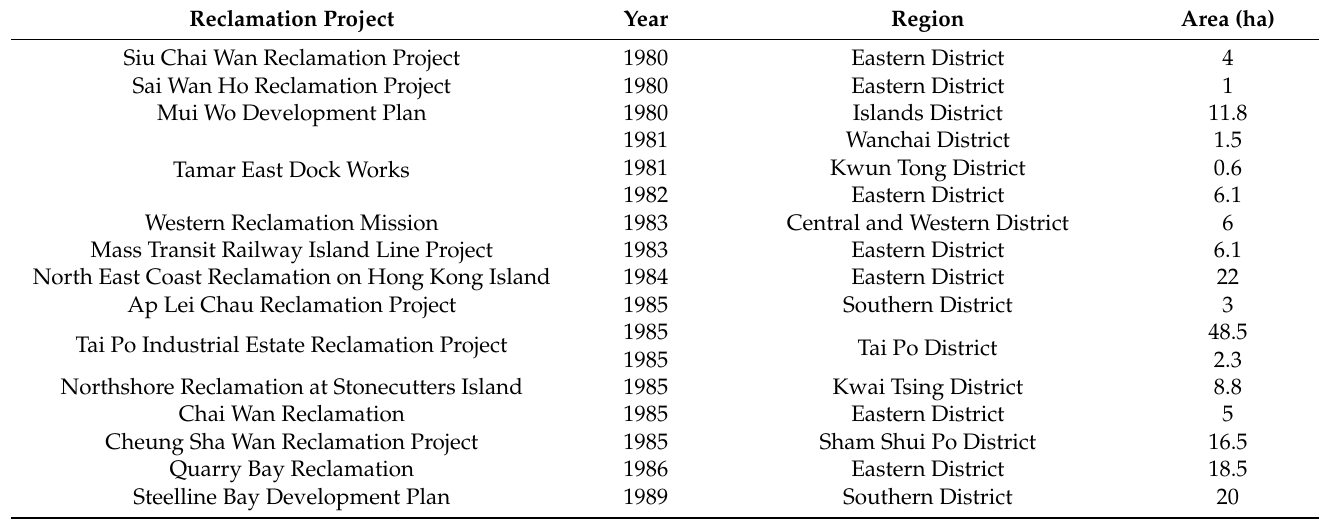
Table 3. Statistical table of reclamation projects in Hong Kong, 1980–1990 (incomplete